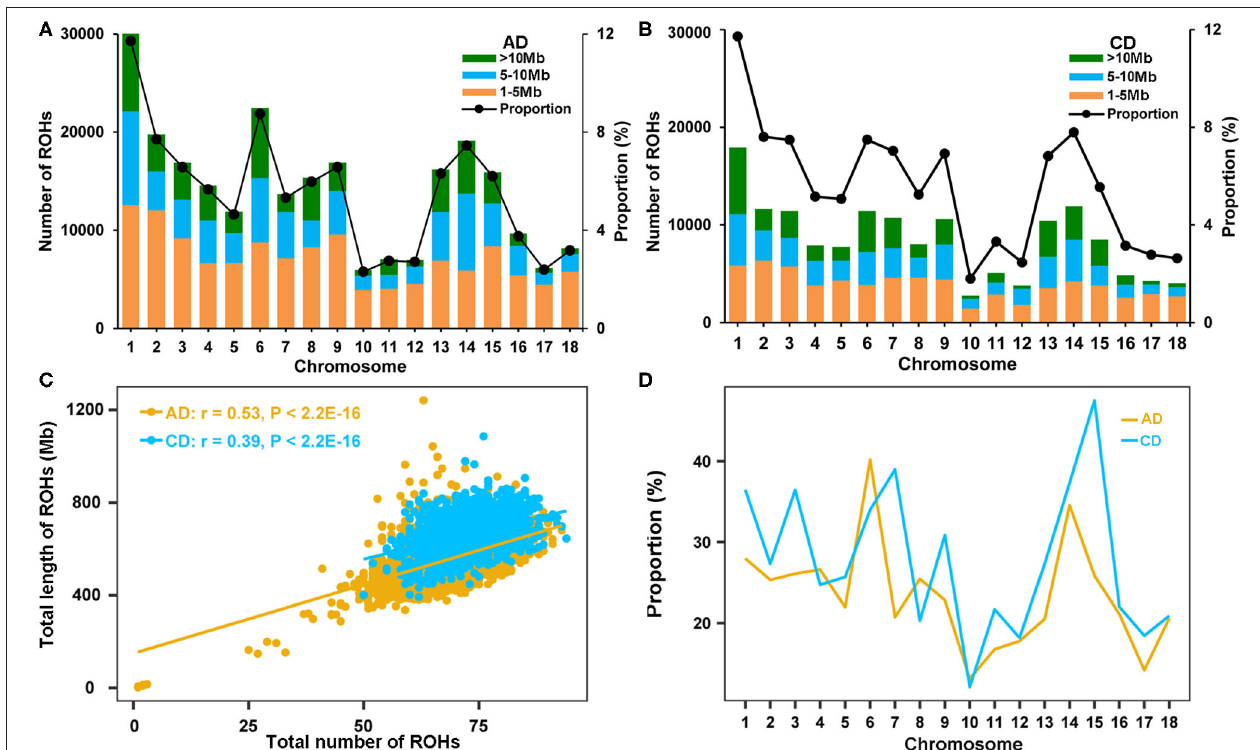
FIGURE 2 | Summary results of ROH in two Duroc lines. (A,B) The number distribution of the three ROH length categories (bars) and average percentage of ROH to the total ROH length (lines) on each autosome of AD and CD pigs, respectively. (C) The total number of ROH and the total length of ROH, per animal, for AD and CD pigs. (D) The average percentage of ROH to chromosome length on each autosome of AD and CD